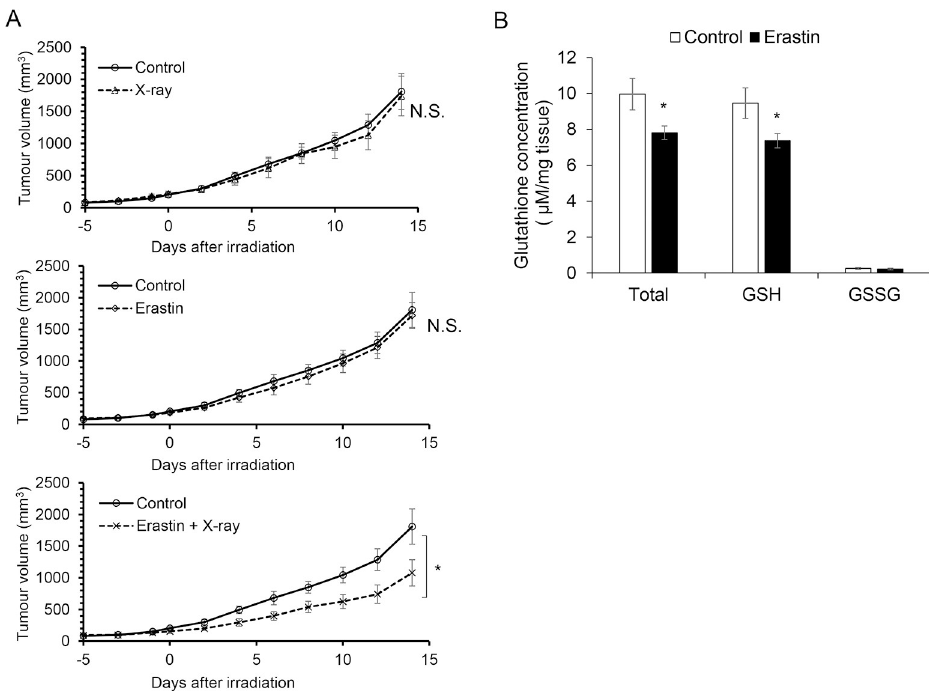
Fig 4. Treatment of NCI-H1975 cell-transplanted mice with erastin showed a tendency of sensitization to X-ray irradiation with a decrease in glutathione concentration. NCI-H1975 cell-transplanted mice were treated with erastin (15 mg/kg intraperitoneally) for 3 days at 24-h intervals and irradiated with X-rays at a dose of 3 Gy. The data are expressed as mean ± S.E. A statistical analysis was performed with repeated-measures two-way ANOVA [n = 5 (Control, X-ray, Erastin), n = 6 (Erastin + X-ray), � p < 0.05] (A). The glutathione concentration was quantified in erastin-treated or untreated NCI-H1975 cell-transplanted mice. Mice were treated with erastin as described above. The data are expressed as mean ± S.E (n = 7, � p < 0.05, Student’s t-test) (B).